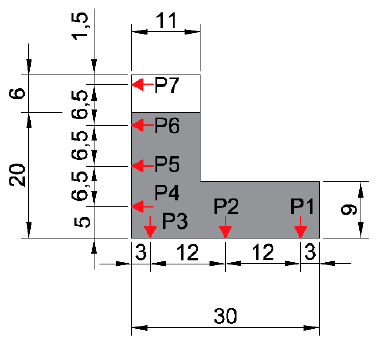
Figure 3. Locations of the pressure sensors in the physical model. Dimensions presented in cm.